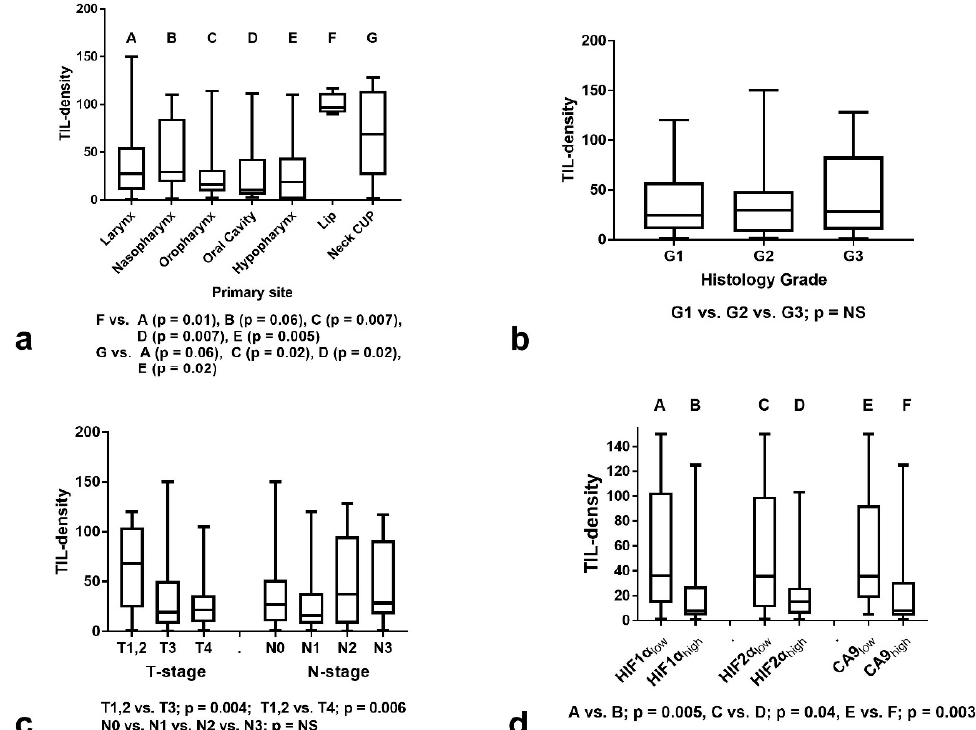
Figure 2. TIL density (mean value of lymphocytes per ×40 o.f.) stratified for histopathological and immunohistochemical variables: ( a ) Stratification according to primary tumor location; ( b ) Stratification according to histology grade; ( c ) Stratification according to T- and N-stage; ( d ) Stratification according to HIF1 α , HIF2 α , and CA9 expression groups. Box and whiskers graphs display the median value, range, and 25th and 75th percentile values. (TIL = Tumor infiltrating lymphocyte, CUP = cancer of unknown primary, G = histology grade, HIF1 α = hypoxia inducible factor 1 α , HIF2 α = hypoxia inducible factor 2 α , CA9 = carbonic anhydrase 9, A,B,C,D,E,F,G correspond to the indications shown on x-axis).